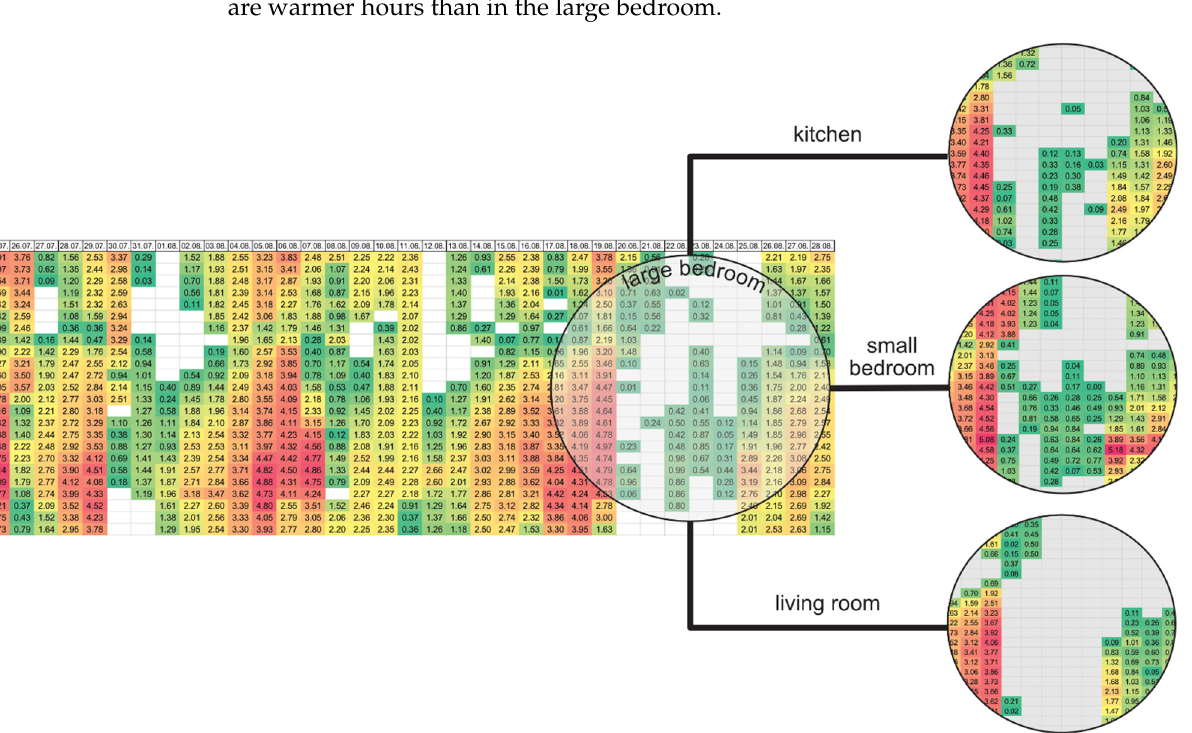
Figure 14. ODH 26 values by hours in the large bedroom, the difference between the rooms between 18 and 28 August